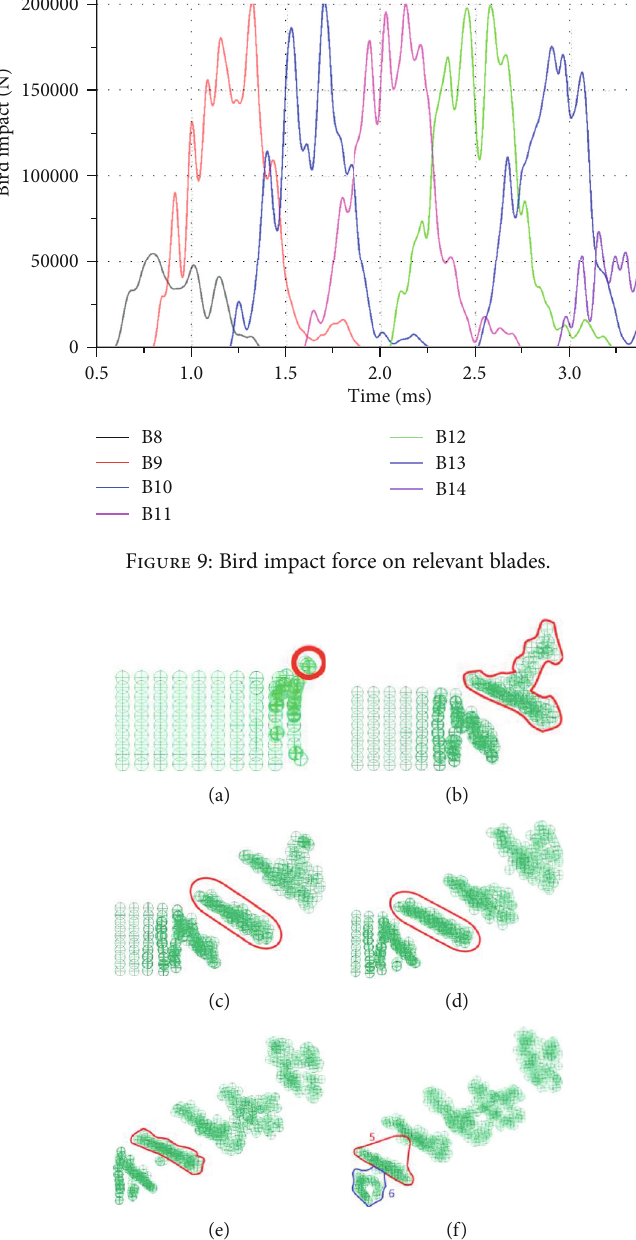
Figure 10: Bird impact fan blades slices: (a) Slice01, (b) Slice01+02, (c) Slice03, (d) Slice04, (e) Slice05, and (f)